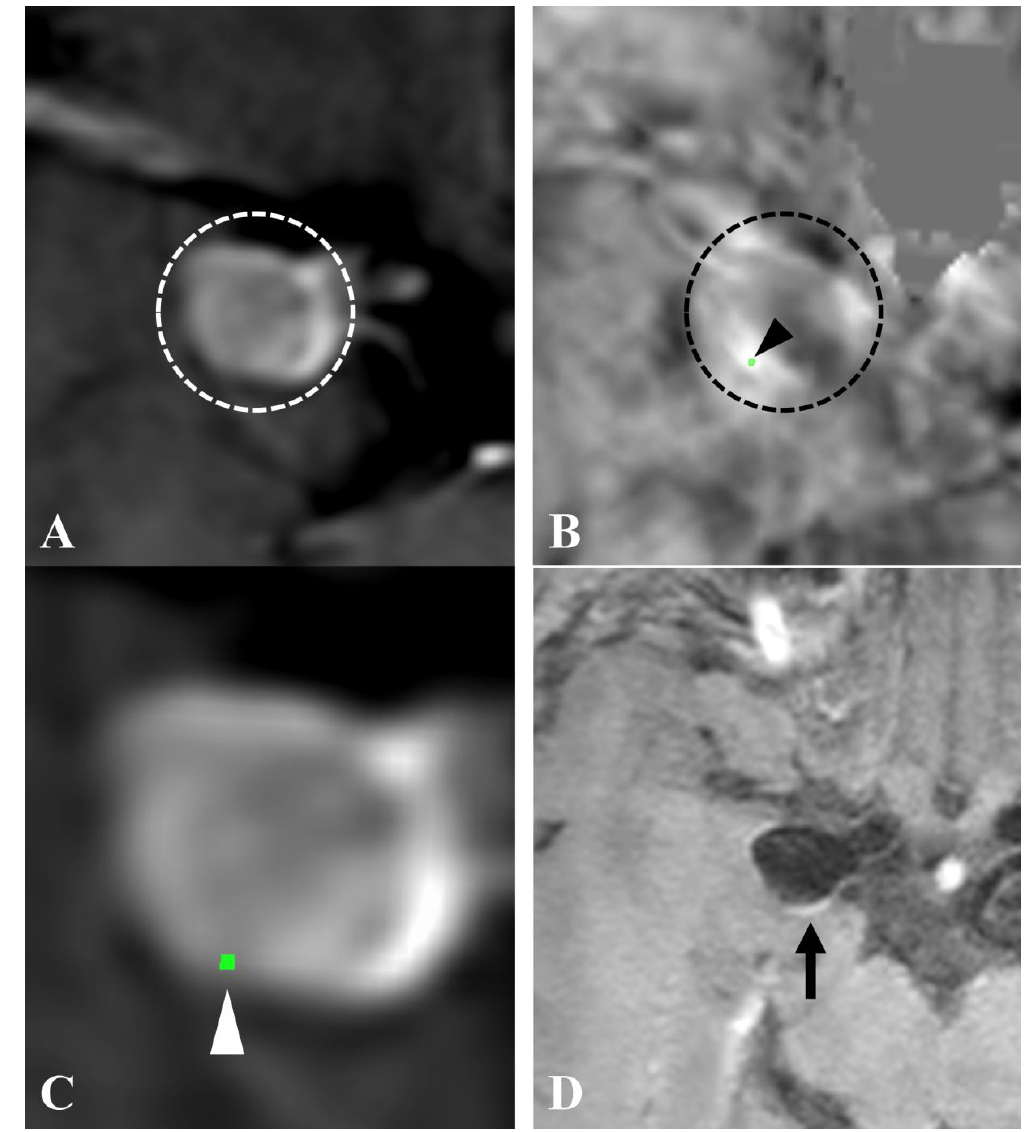
Figure 2. QSM and vessel wall imaging (VWI) of an intracranial aneurysm with